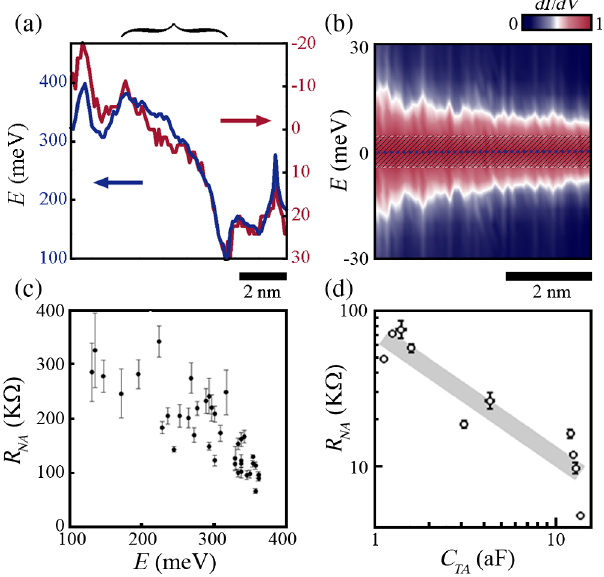
FIG. 8. (a) Trace of the resonance peak [Fig. 2(b)] showing its peak position (blue line) and the midgap position (red line), illustrating their anticorrelated dispersion. Note the opposite and scaled corresponding voltage axes. (b) Enlarged bias window of the dI=dV centered around the dispersing resonance peak from Fig. 2(b) extracted across the top region of the drop which shows continuous topographic and spectroscopic profiles marked with a curly bracket in (a). The shaded region indicates the instrumental broadening. (c) A plot of R at different bias NA voltages extracted from the energy broadening shown in (b). It confirms that the tunnel barrier is energy dependent, and that closer to the bottom of the band the resistance increases. the power-law ∼ C − α R , expected from the geometrical dependence of NA NA these parameters with α ≈ 0 . 8 .